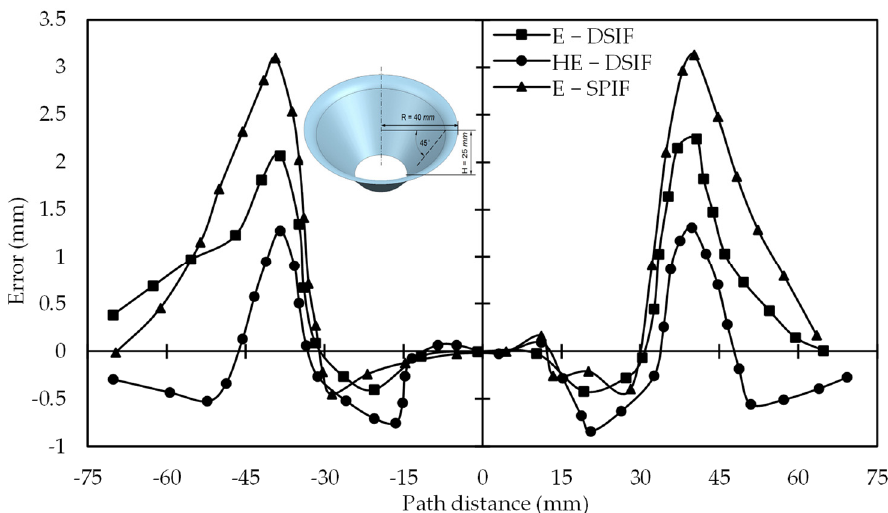
Figure 18. Geometric error in formed part in clamped position for E-SPIF, E-DSIF, and HE-DSIF (reprinted with permission from Xu et al. [78], Copyright 2016 Elsevier).